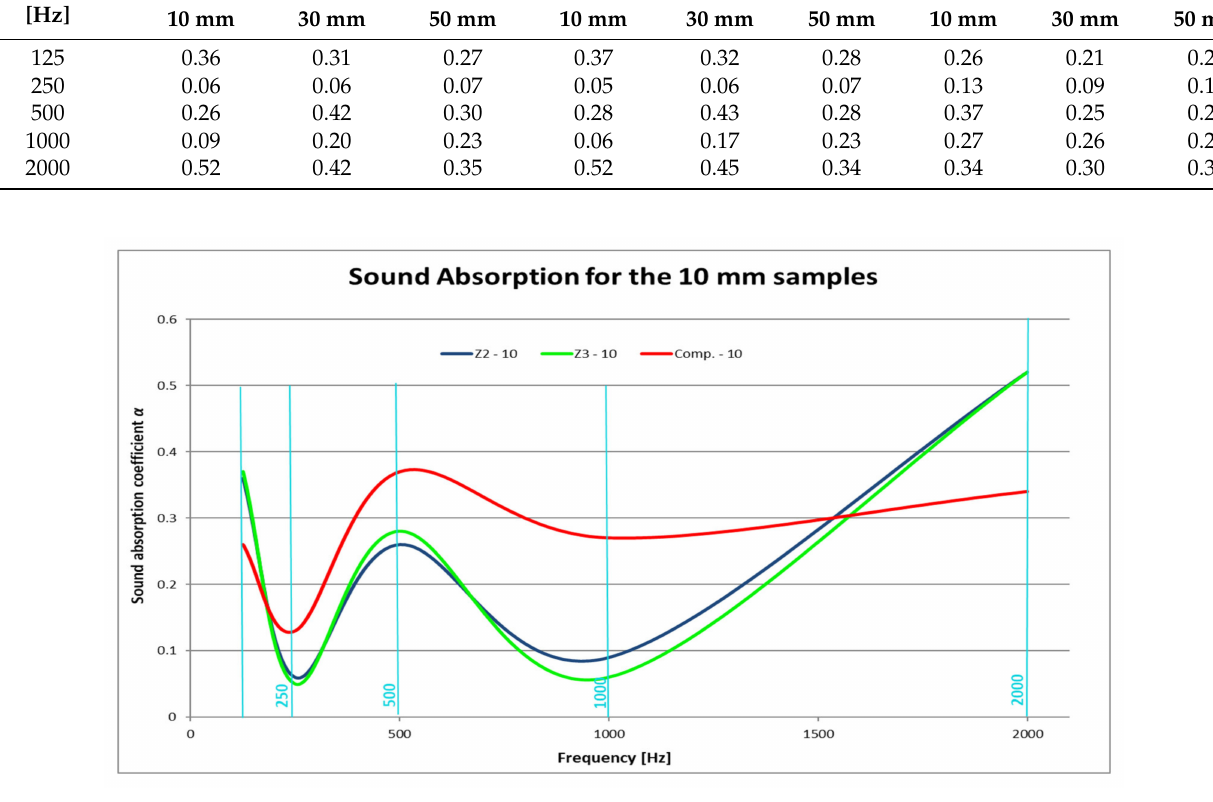
Figure 6. Sound absorption of cement composites th. 10 mm.